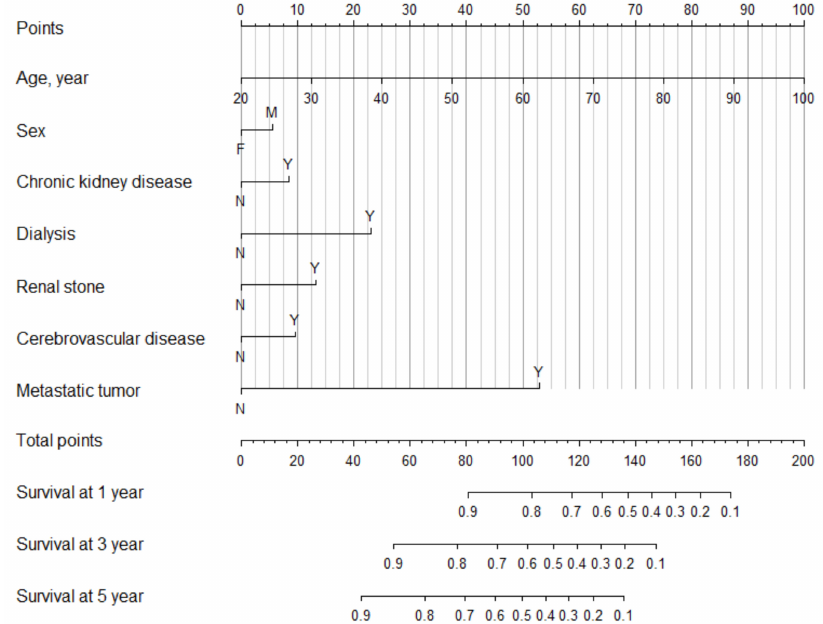
Figure 2. Nomogram prediction for 1-, 3-, and 5-year survival of kidney cancer. This nomogram tool is a direct representation of cox model given in Table 2. (Note: For a given patient profile, each predictor has a corresponding risk score (0–100) on the top “Points” scale. The risk scores from each predictor are summed to obtain a total point value. The total points are then indicated on the Total Points Scale (forth from the bottom). Finally, the corresponding predicted 1-, 3-, and 5-year survival is determined by drawing a vertical line down from the total points scale to the Predicted Survival Probability scale at 1, 3 and 5 years (the bottom three scales).